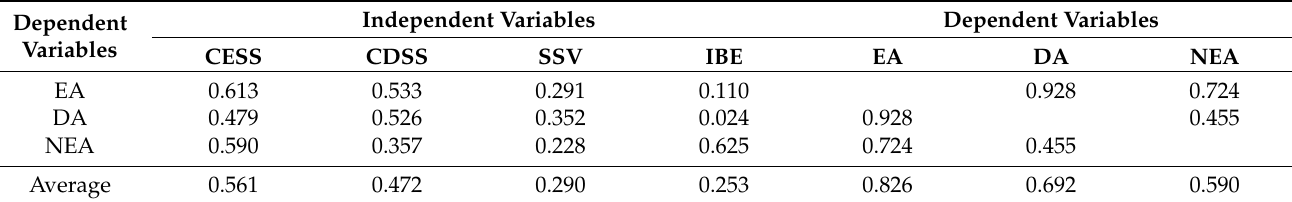
Table 5. Spearman correlation coefficients among key